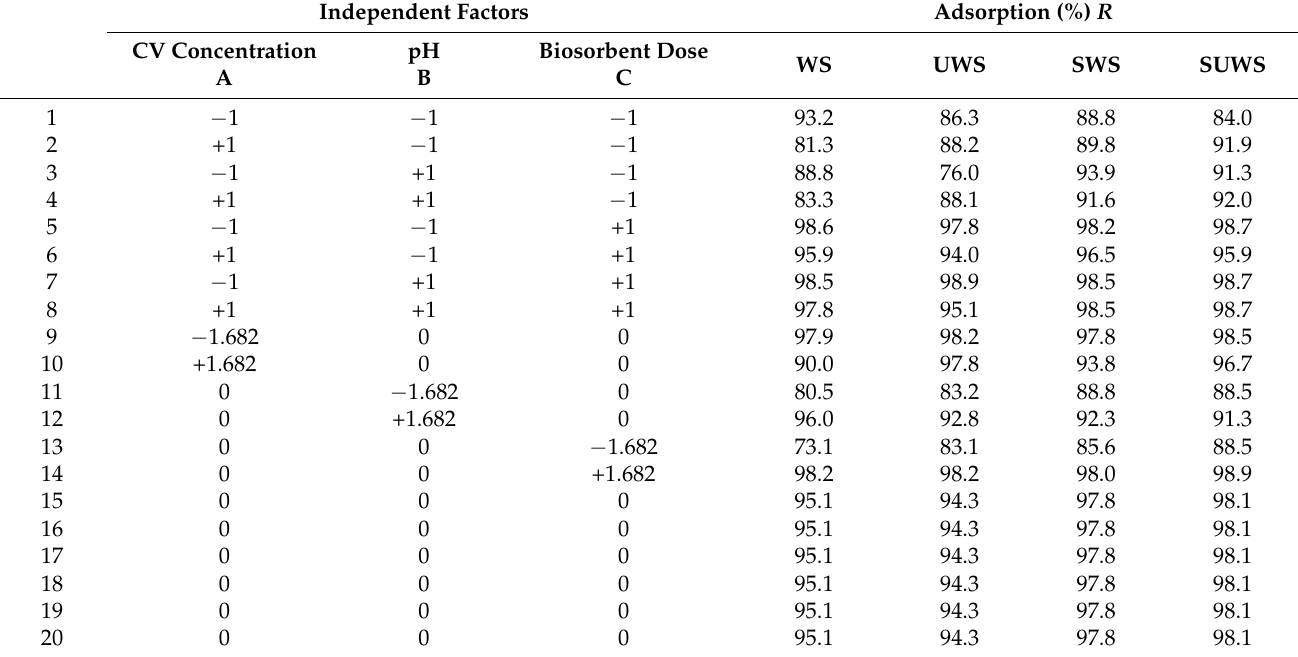
Table 2. Experimental runs according to the central composite design for three independent variables.